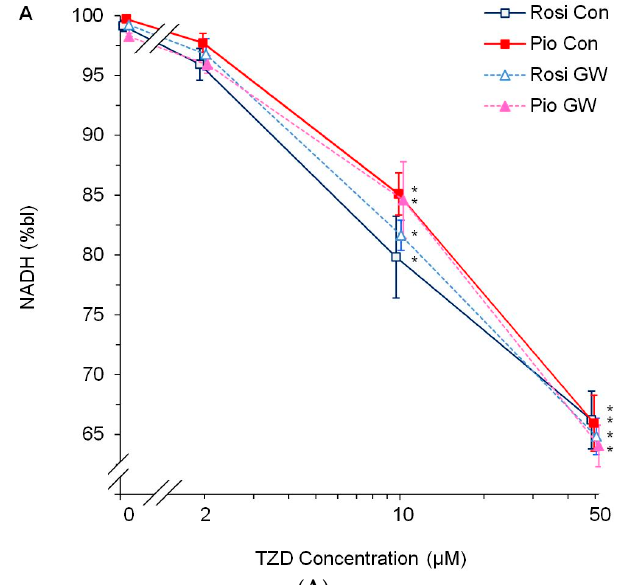
Figure 2. Shows representative time courses of NADH (closed blue circles) and FAD (open green diamonds) autofluorescence for an experiment with rosiglitazone (Rosi) in increasing doses from 0 to 50 µM (5 min each) first in the absence and then, after a 30 min washout period, in the presence of the PPAR γ antagonist GW9662 (GW, 10 µM).